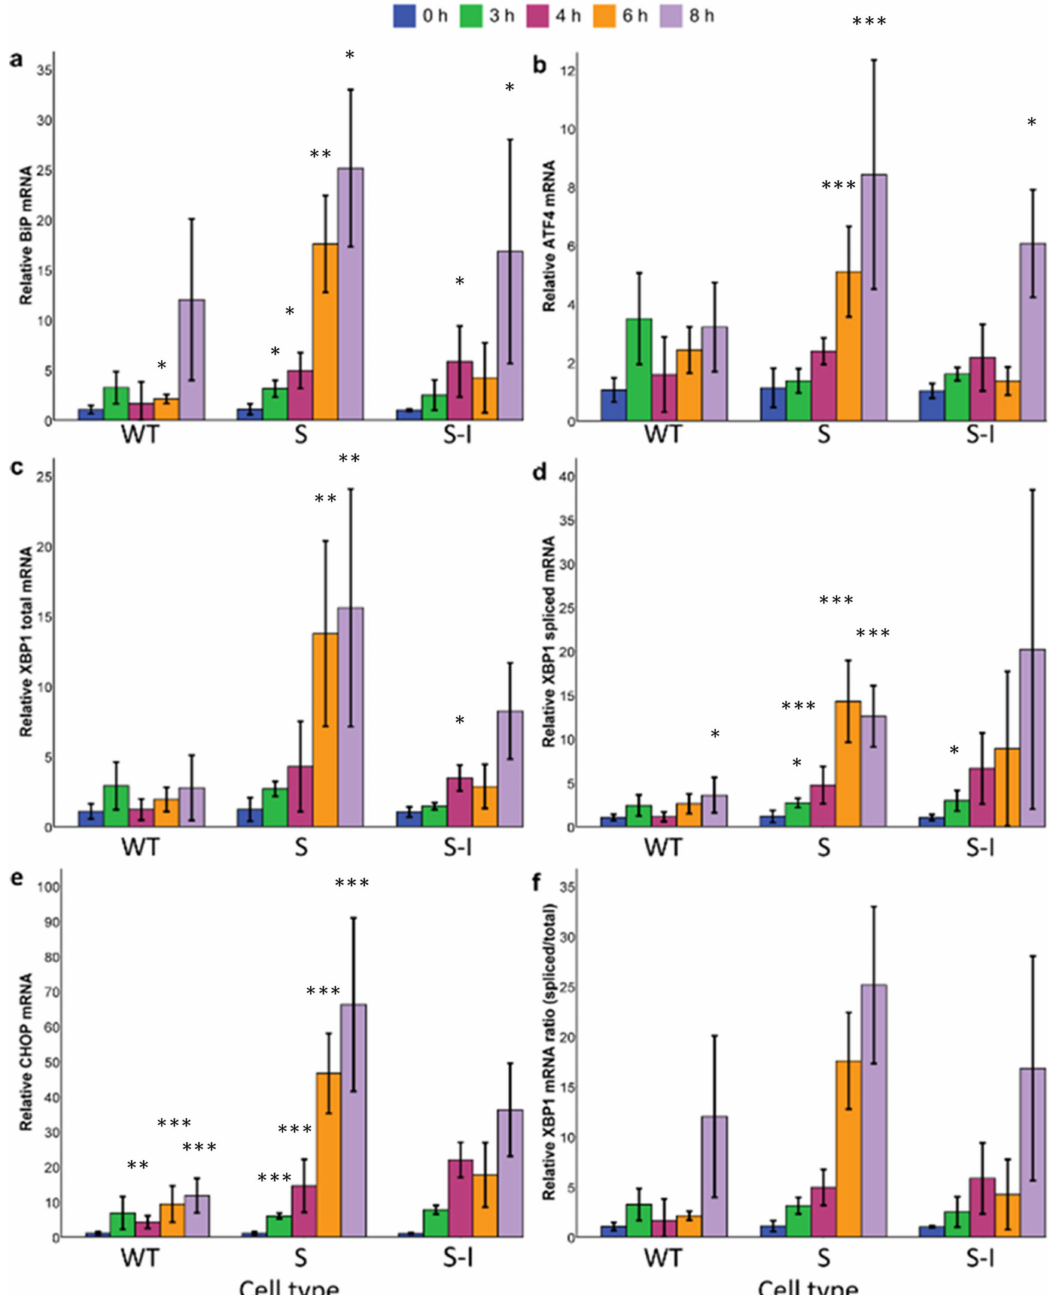
Figure 3. qRT-PCR analysis to monitor the expression of UPR markers in a cell-model system of FAD during Tm treatment. Differentiated SK-N-SH cells stably overexpressing wild-type (APP WT ), Swedish (APP S ), or Swedish-Indiana (APP S-I ) mutant forms of APP695 were treated with tunicamycin (Tm) for 8 h. The transcript levels of the UPR targets ( a ) BiP, ( b ) ATF4, ( c ) XBP1 total, ( d ) XBP1 spliced, and ( e ) CHOP were assessed with qRT-PCR. Samples were normalized to 18S rRNA and the 0 h time point for the respective gene. ( f ) The ratio of XBP1 mRNA spliced/total was calculated from the qRT-PCR data. Values represent the mean for n = 5. These are from two independent biological experiments, where the technical replicates for each experiment were n = 3 and n = 2, respectively. Each sample was analysed with n = 3 qRT-PCR technical replicates. * p < 0.05, ** p < 0.01, *** p <